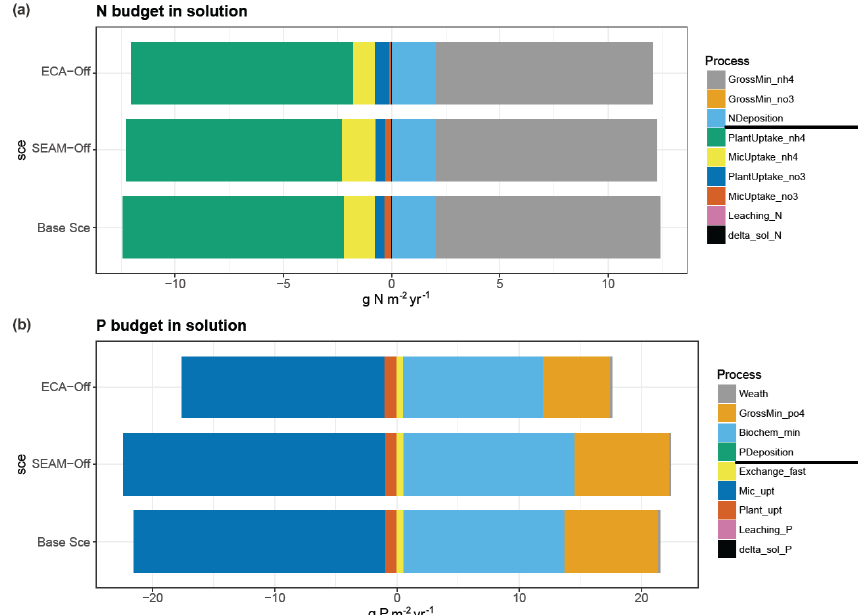
Figure 7. Simulated yearly budget of (a) N and (b) P in soil solutions. In (a) , sourcing fluxes of N are presented in the order of gross mineralisation of NH 4 and NO 3 and N deposition (in the bar plot: from right to the zero point; in the legend: from the top to the separation line); sinking fluxes of N are presented in the order of plant and microbial uptakes of NH 4 , plant and microbial uptakes of NO 3 , N leaching (both inorganic and organic), and changes in soluble N content (delta_sol_N) (in the bar plot: from left to the zero point; in the legend: from the separation line to the bottom). In (b) , sourcing fluxes of P include weathering, gross mineralisation of PO 4 , biochemical mineralisation of PO 4 and P deposition; sinking fluxes of P includes adsorption (Exchange_fast), microbial and plant uptakes, P leaching (both inorganic and organic), and changes in soluble P content (delta_sol_P). (The order of presented processes follows the same rule as N.) The budgets are calculated using data from the full simulation (200 years) of the model